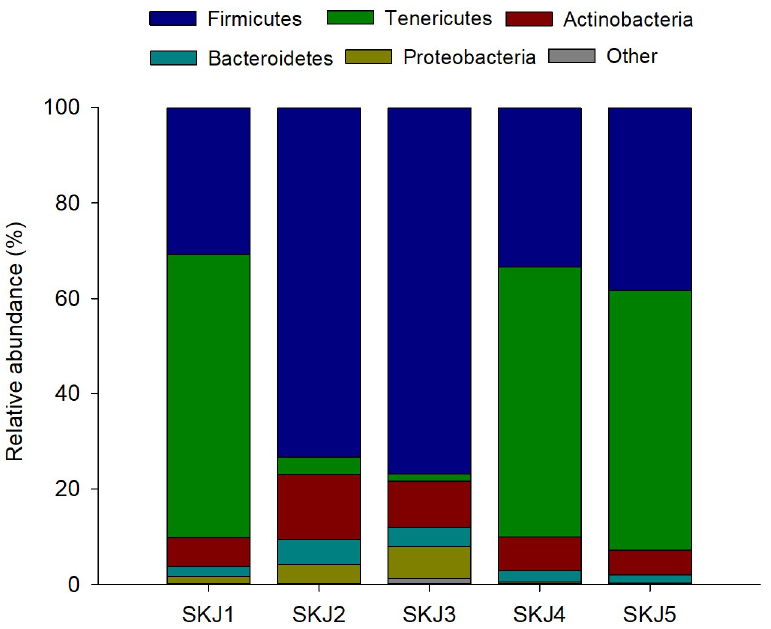
Fig 6. Gut bacterial ecosystem at phylum level. Taxonomic composition of the phyla level (%) of gut microbiota of five individuals of Katsuwonus pelamis (SKJ). The plots represent the most abundant representative phylum ( > 2%). https://doi.org/10.1371/journal.pone.0249541.g006 for proximate composition analysis, without excluding the vertebral spine, which increased fishbone content in the sample if compared with studies using only the muscle filet. Compar- ing between the targeted species in this study, moisture, ash and protein content was similar between skipjack tuna and the Atlantic bonito. The fat and protein content of a fish are the main parameters to consider when evaluating the animal nutritional condition [34]. With an average of 23% of protein, results support a higher protein content of tunids when compared with other marine fish species, such us the Bombay duck ( Harpadon nehereus ) or the unicorn cod ( Bregmaceros mcclellandi ), with 10 ± 2.0% and 15 ± 1.1% of protein, respectively [35], standing out as an excellent source of high-quality protein. Regarding lipids content, the skip- jack tuna showed significantly lower amount of lipids, with more than 2-fold decrease when compared to the Atlantic bonito. The lower content of lipids in the skipjack tuna might be explained by the highly migratory nature of this species. It has been reported skipjack tuna migrations to the western Mediterranean Sea in summer for spawning [36]. Thus, the loss of energy density may be a result of depletion of lipid reserves to satisfy the migratory energetic